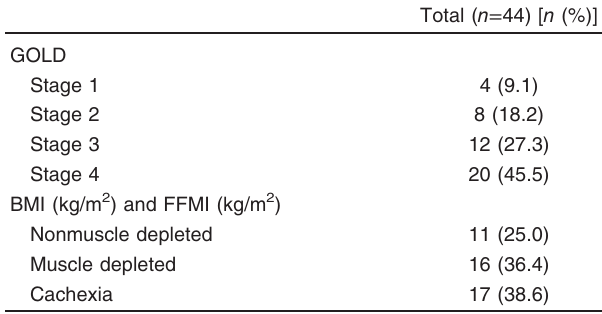
Table 1 Clinical characteristic of the patients